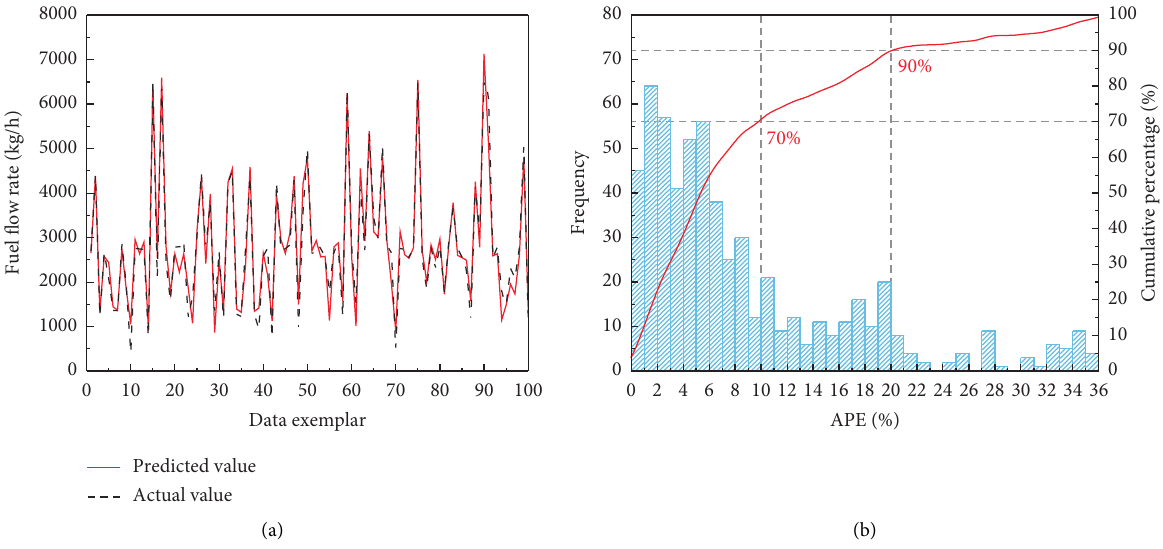
Figure 4: Testing results of GA-WNN model by (a) the comparison of the predicted and actual FFR values for 100 exemplars; (b) the cumulative distribution of absolute percentage error (APE) for 500 data points.